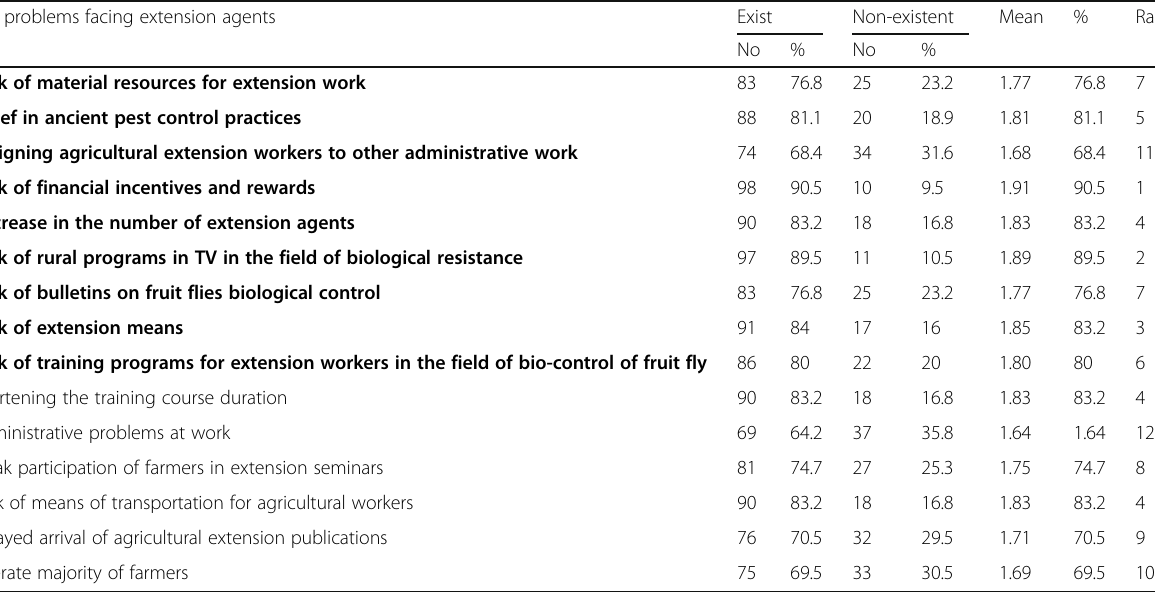
Table 8 Distribution of agricultural extension agents according to the problems facing extension agents in the field of biological control of fruit flies The problems facing extension